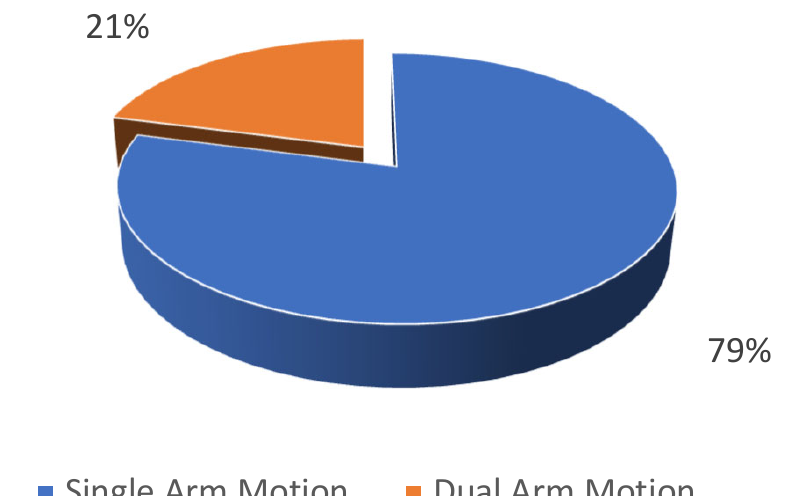
Figure 4. Comparative analysis of the biomimetics approach on single vs. dual robotic